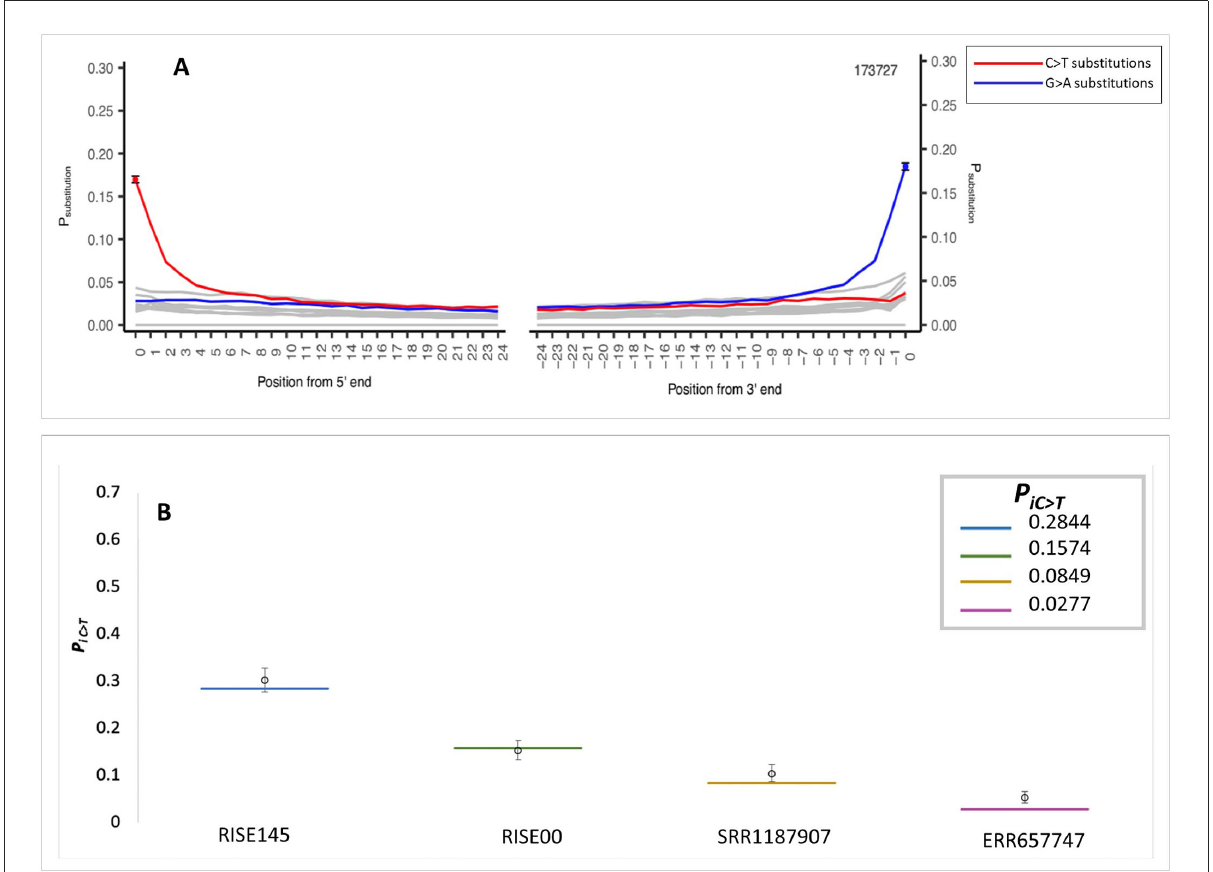
FIGURE4 MetaDamage outputs— (A) Authentic Holocene Viridiplantae dataset. (B) Credible intervals observed in simulation data using authentic sequence dataset with damage parameter mapped